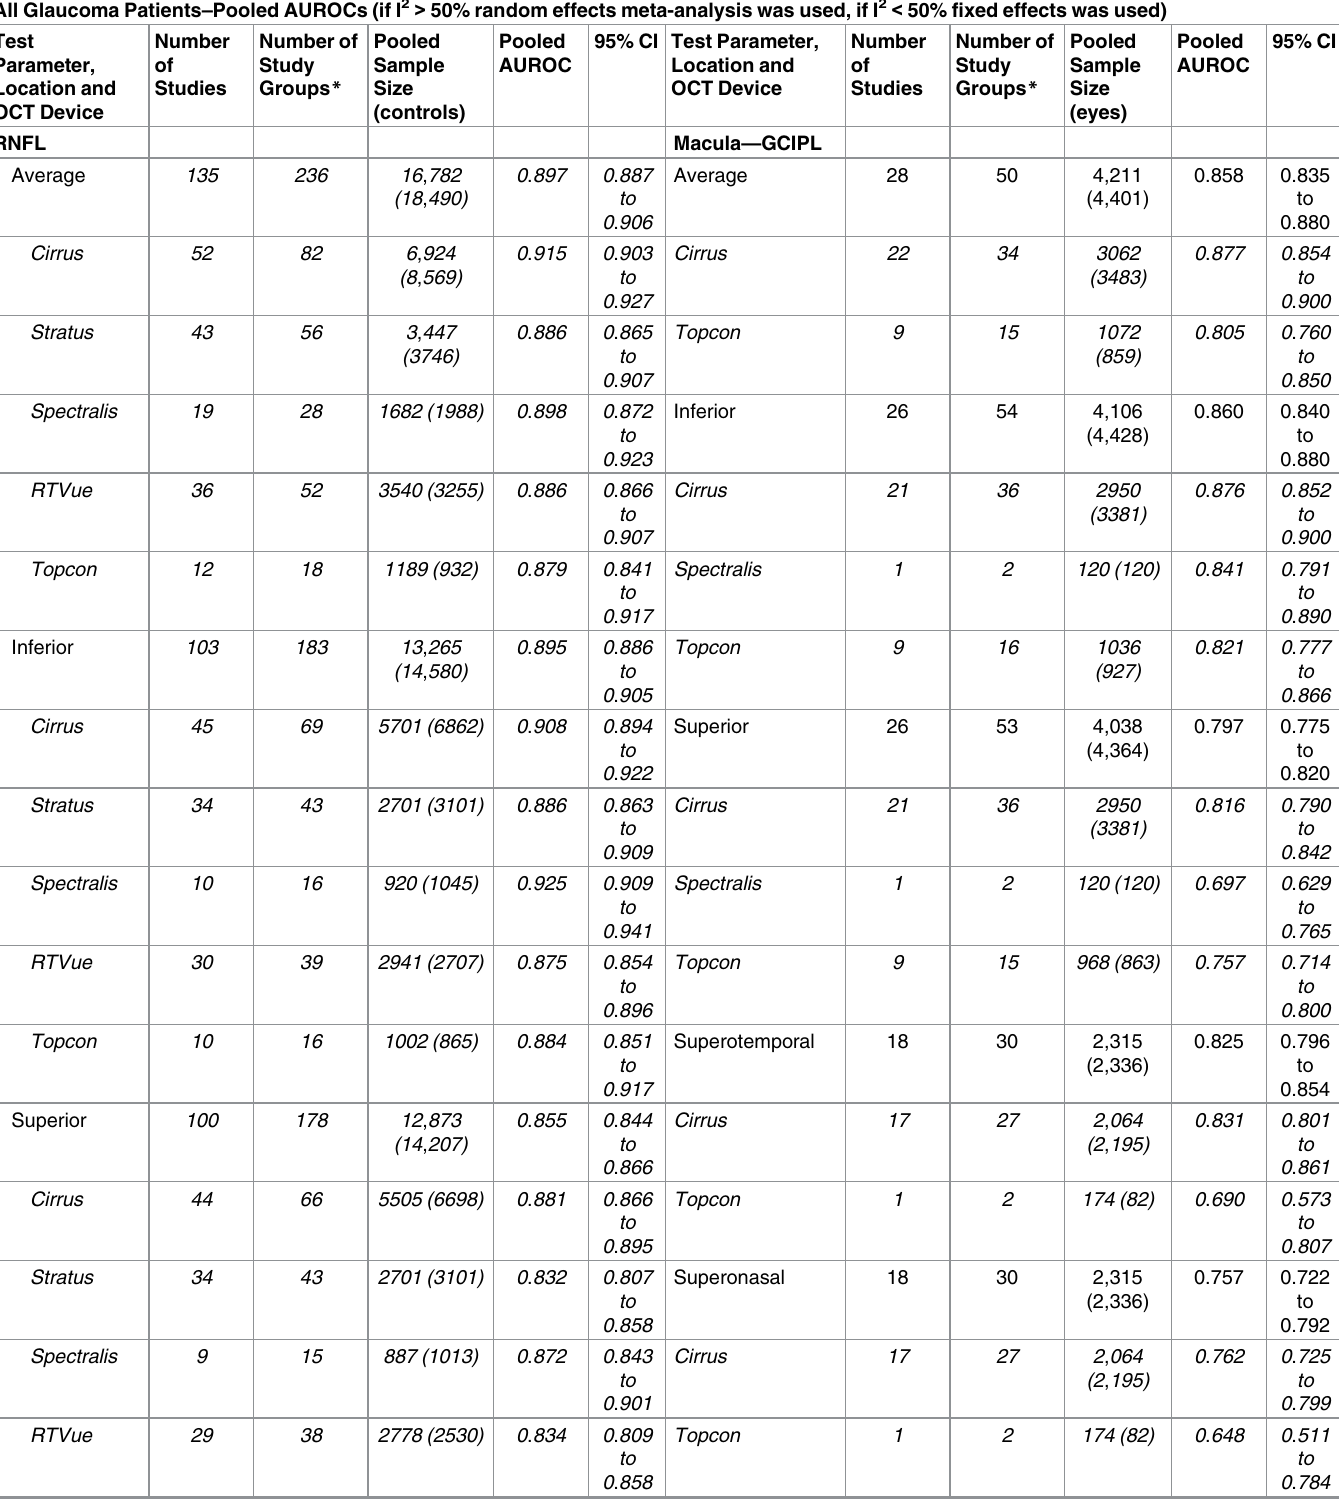
Table 2. Pooled AUROCs of RNFL and macular OCT parameters for all glaucoma